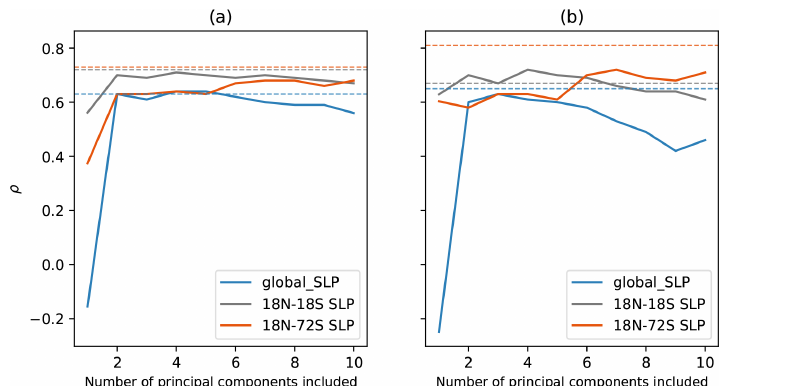
Figure A13. Comparison of linear regression based on SLP principal components to ridge regression based on SLP fields in the period of (a) 1959–2017 and (b) 1980–2017. The label of the y axis shows the Pearson correlation between the predicted and original CO 2 time series. The solid lines represent the results by using the linear regression based on a different number of SLP principal components as predictors. The dashed lines represent the results by using ridge regression. Differently colored lines represent different SLP spatial domains